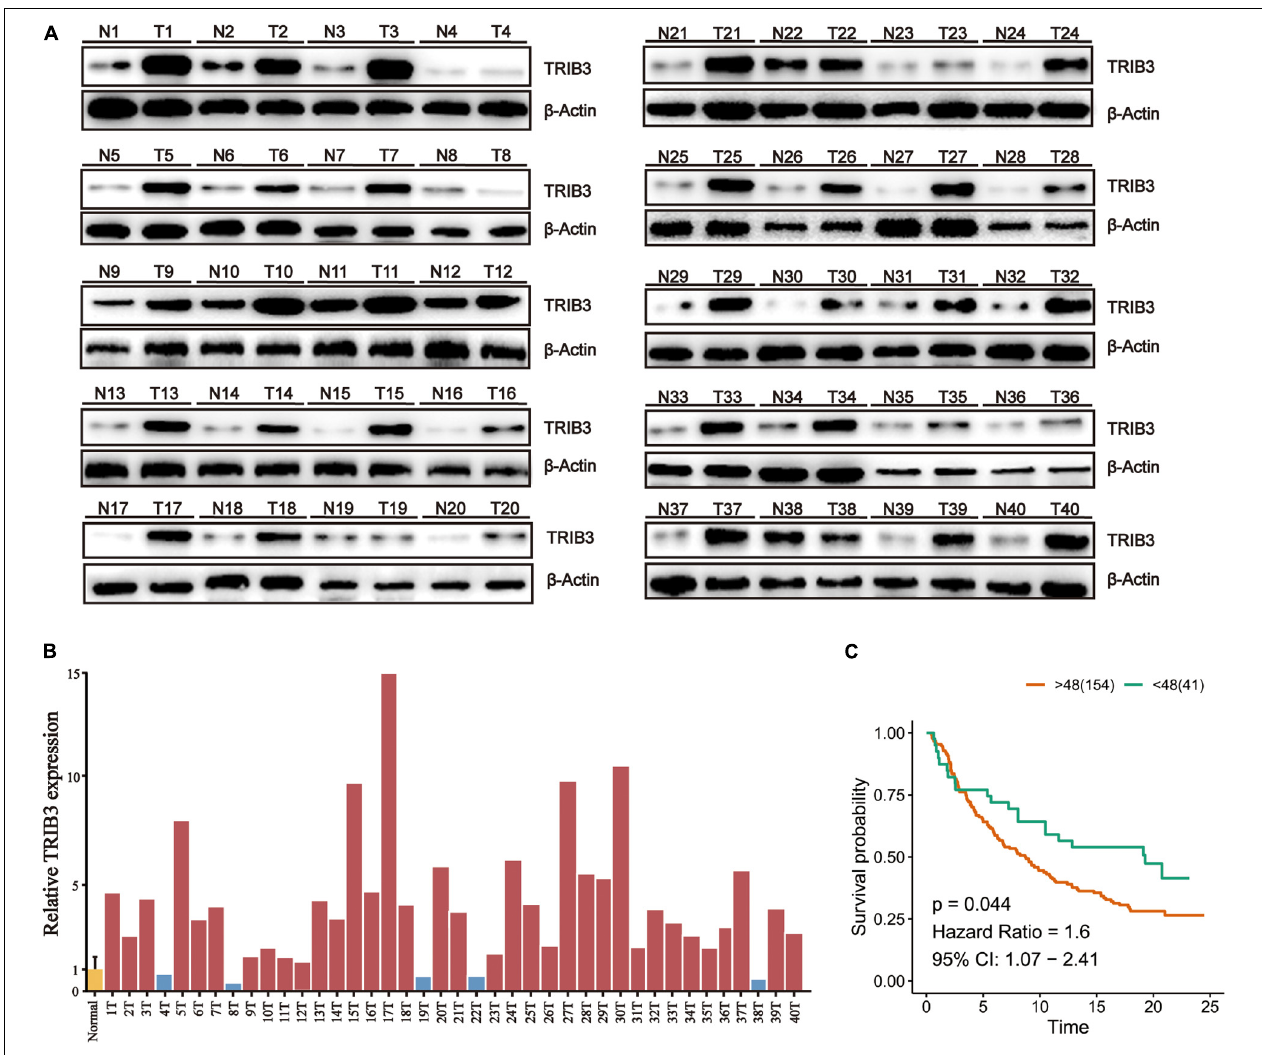
FIGURE 5 | High TRIB3 expression in bladder cancer tissues of patients. (A) The expression of TRIB3 protein in bladder cancer tissues and paracancer tissues by western blot (B) The relative gray values of TRIB3 protein in bladder cancer tissues. (C) Kaplan–Meier analysis of TRIB3 expression in validation cohort.